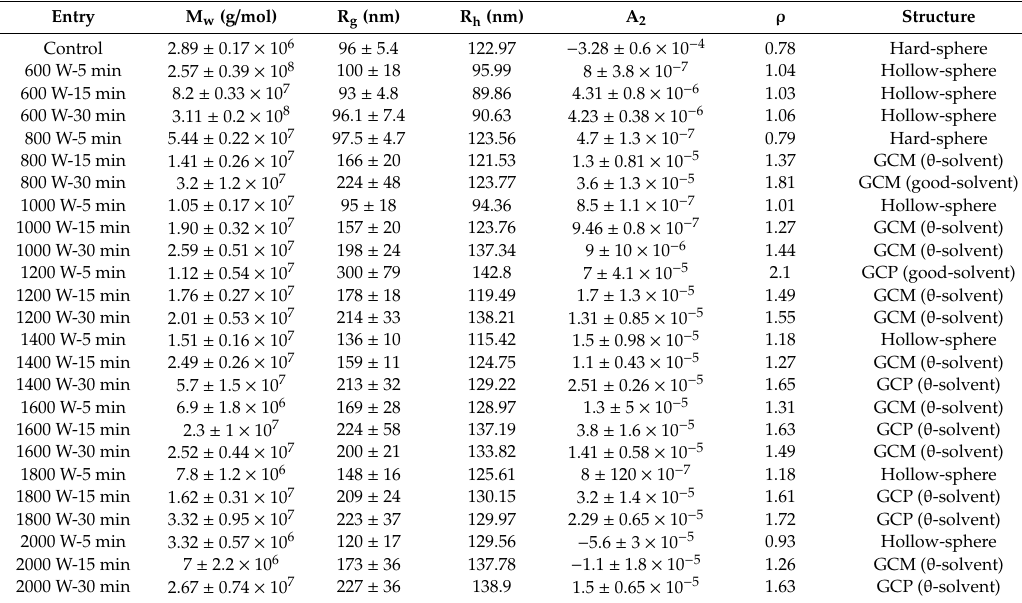
Table 1. Summaries of dynamic and static light scattering data on the soluble aggregates in the SPI aqueous solutions after HIU